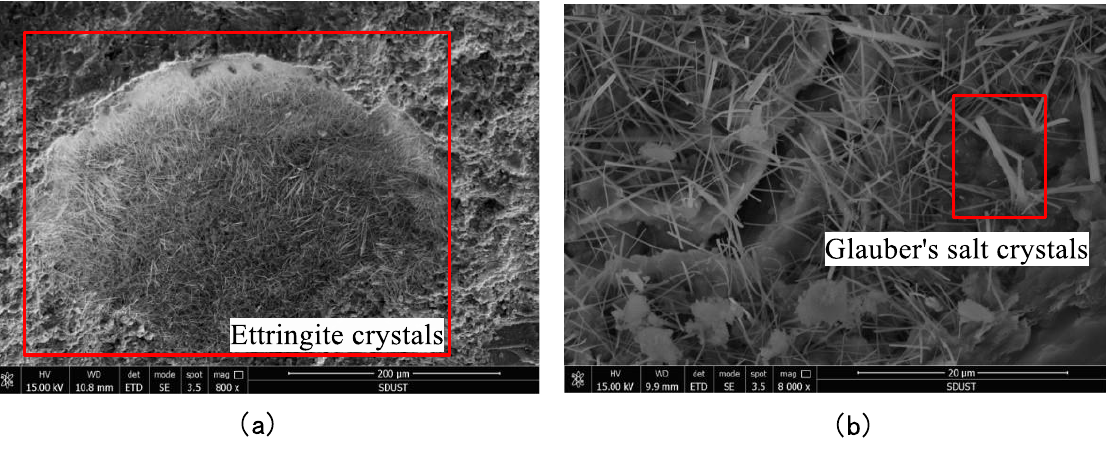
Figure 9. SEM images showing ettringite and mirabilite. ( a ) Ettringite crystals marked by red box. ( b ) Glauber's salt crystals marked by red box. ( b ) Glauber’s salt crystals marked by red